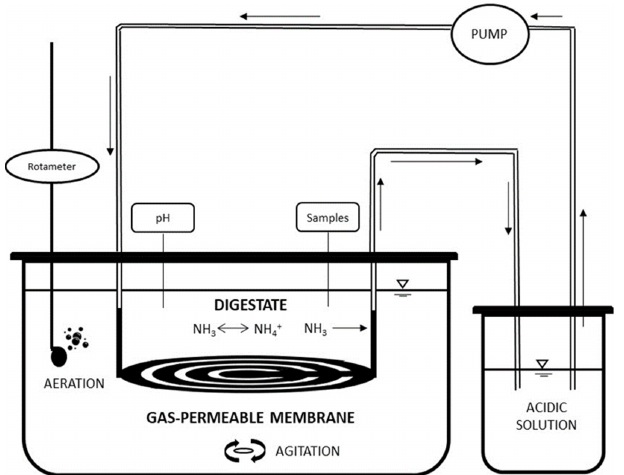
Figure 3. Experimental set-up of the N recovery experiments using the gas-permeable membrane technology. The arrows indicate the direction of the flows. The pH measurement and sampling were carried out through the reactor